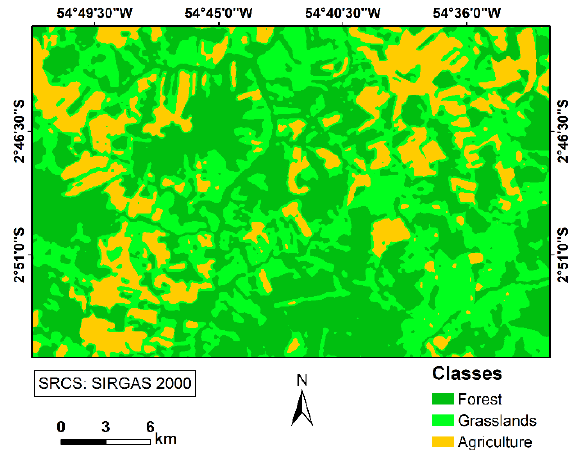
Figure 7. Classification map obtained using the combined VV and VH time series features